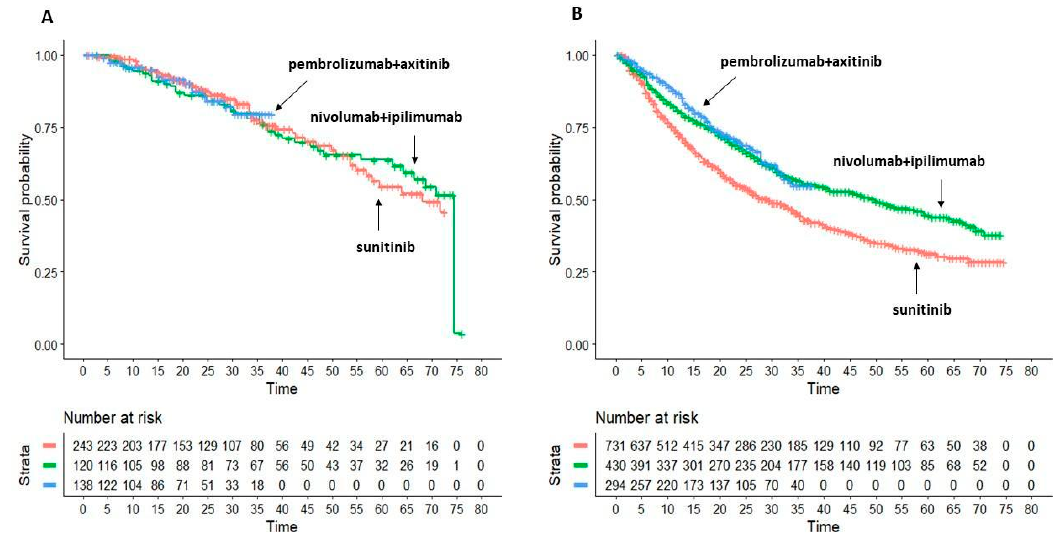
Figure 4. Overall survival Subgroups analysis. ( A ) In favourable-risk patients; application of the Shiny method to sunitinib monotherapy ( n = 243 from 2 trials; in red) and to 2 combination treatments: (a) nivolumab 3 mg/kg + ipilimumab 1 mg/kg ( n = 120; in green) and (b) pembrolizumab 200 mg + axitinib 5 mg ( n = 138; in blue). ( B ) In intermediate-risk/poor-risk patients; Application of the Shiny method to sunitinib monotherapy ( n = 731 from 2 trials; in red) and to 2 combination treatments: (a) nivolumab 3 mg/kg + ipilimumab 1 mg/kg ( n = 430; in green) and (b) pembrolizumab 200 mg + axitinib 5 mg ( n = 294; in blue). n : number of enrolled patients. End-point: overall survival (OS), Time in months.